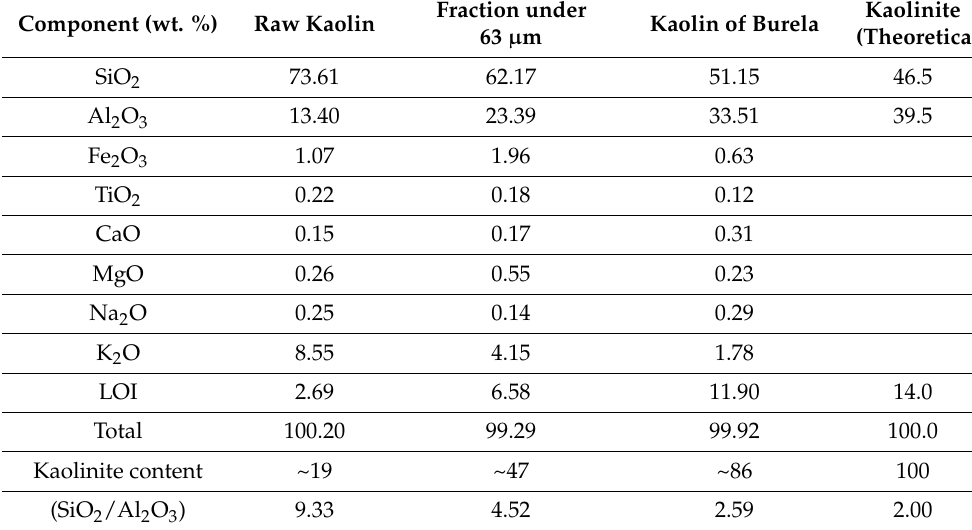
Table 2. Chemical analysis by XRF of the raw kaolin sample and its fraction under 63 µ m obtained by washing. It is included the chemical analysis of a sample of ceramic kaolin (washed sample) of Burela (Lugo, Spain). LOI = ”Loss on ignition” or loss of weight after heating at 1000 ◦ C for 1 h. An estimation of the kaolinite content in the samples is calculated on the basis of the LOI results. The molar ratio [SiO 2 /Al 2 O 3 ] is given for the samples. Kaolinite Fraction under Kaolin of Burela Component (wt. %) Raw Kaolin (Theoretical) 63 µ m SiO 2 73.61 62.17 51.15 46.5 Al 2 O 3 13.40